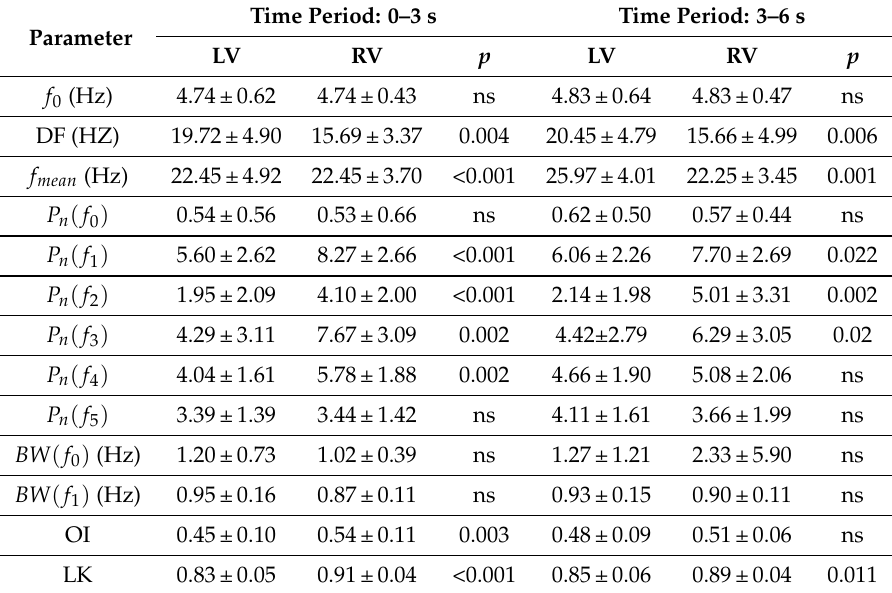
Table 1. Spectral parameters for the two analyzed time periods in the VF episodes.